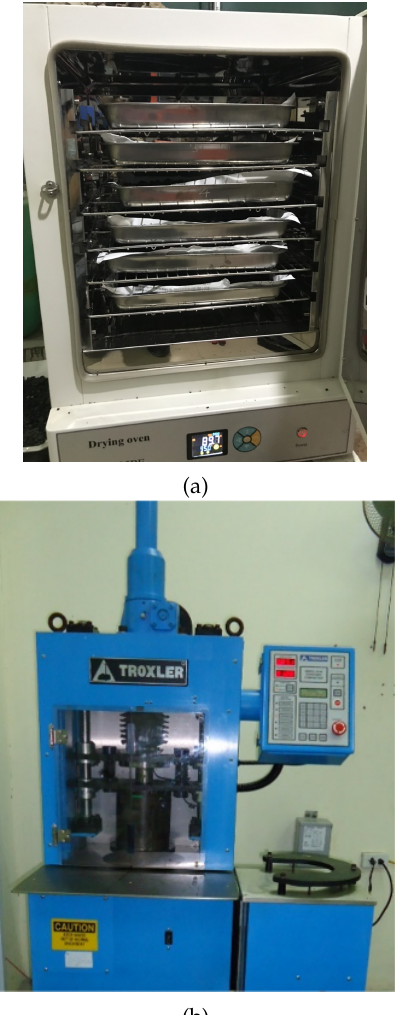
(Fig. 1a). rPE connects aggregates to aggregates, cre- ating a firmly bonding system for materials (Fig. 1b).